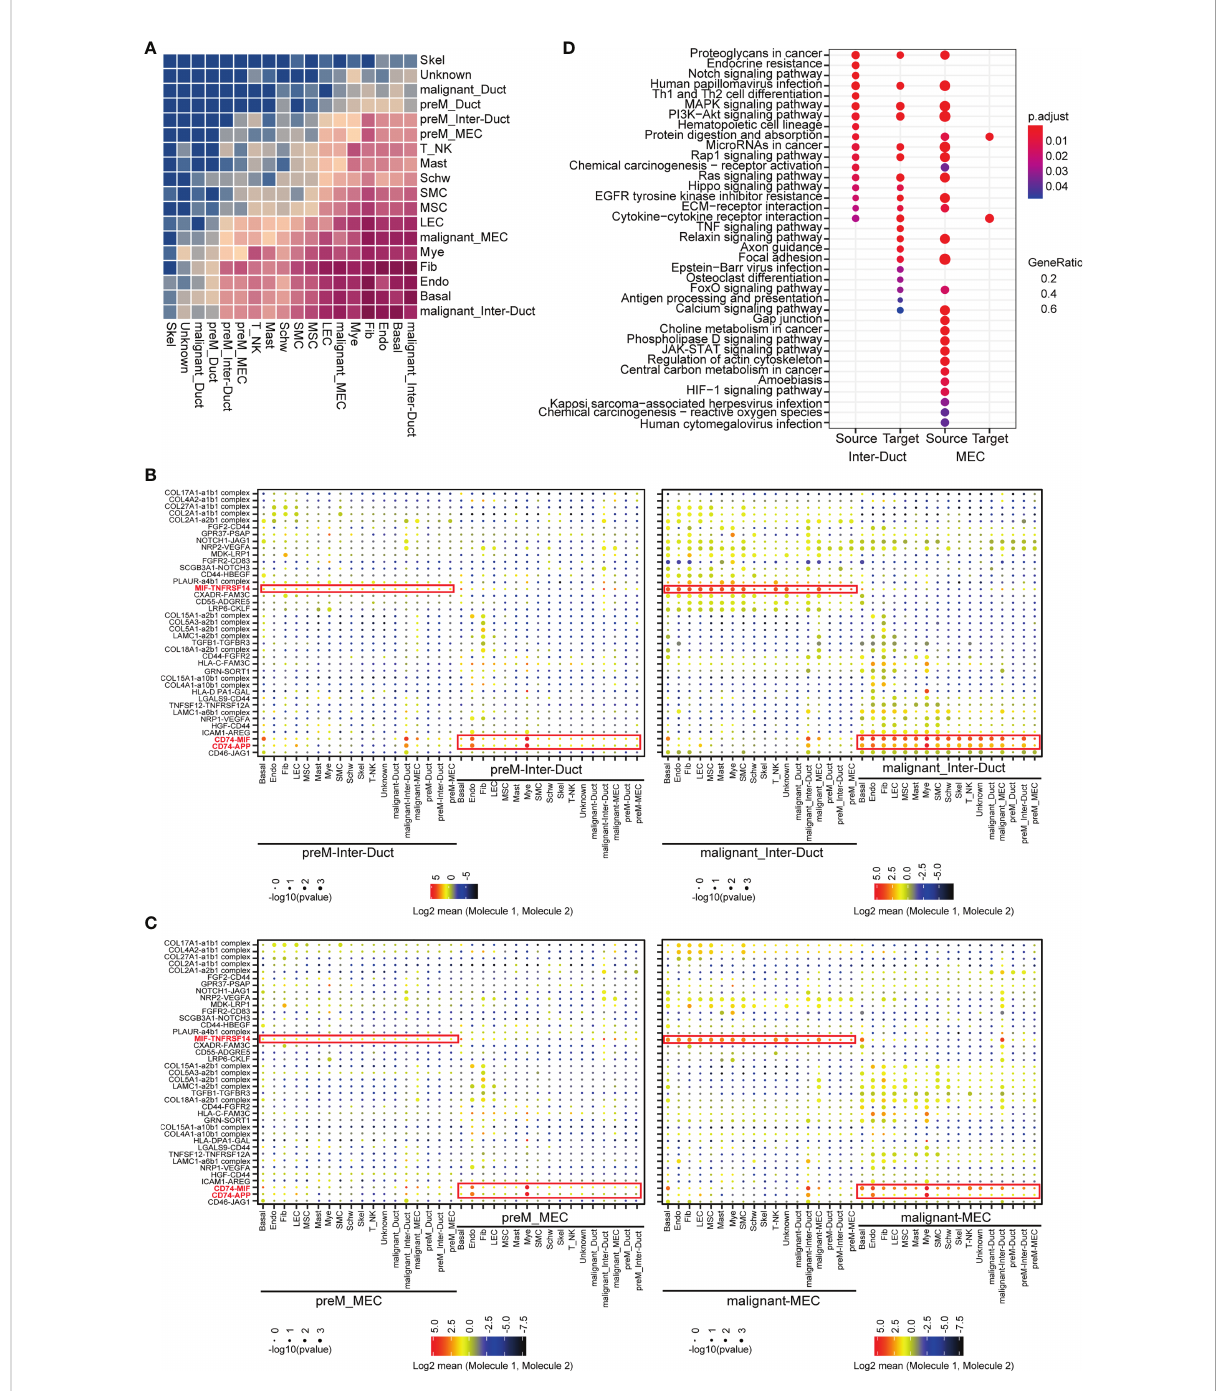
FIGURE 6 Intercellular interactions in ACC. (A) Heatmap showing the relative strength of cellular communication between different cell types. The depth of rectangular color is positively correlated with the number of interacting receptors-ligand pairs between cell types. (B) Dot plot showing the mean expression level and p-values for the selected interacting partners between other cells and intercalated duct-like cells. The interacting communication with Pre-M Inter-Duct was shown in left and those with malignant Inter-Duct was shown in right fi gure. (C) Dot plot showing the mean expression level and p-values for the selected interacting partners between other cells and myoepithelial-like cells. The interacting communication with Pre-M MEC was shown in left and those with malignant MEC was shown in right fi gure. (D) Dot plot showing the results of KEGG enrichment analysis for upregulated receptor and ligand genes in different groups, which were cell pairs with malignant Inter-Duct-like cells or MEC-like cells as “ Source ” or “ Target ”